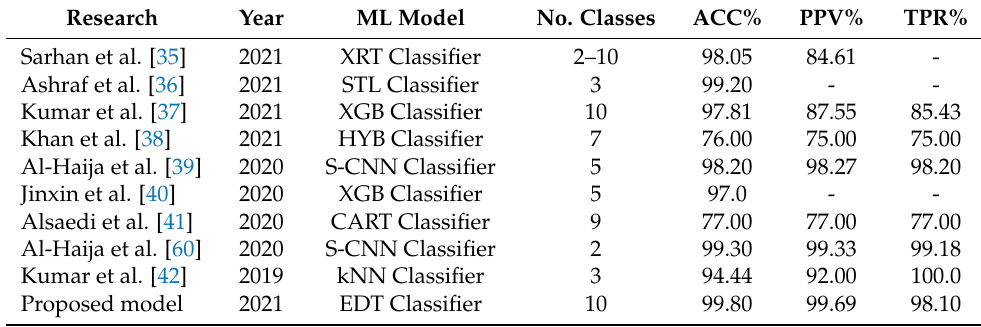
Table 8. Comparison with other existing ML-based IoT-IDS